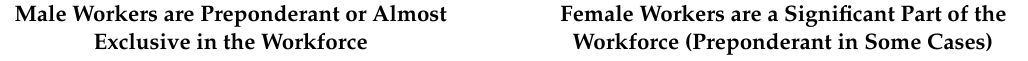
Table 1. A non-exhaustive list of outdoor working profiles and activities, distinguishing those with a prevalence of male workers from those with a significant presence of female workers. In some cases, an activity displays a prevalence of male workers together with a significant presence of female workers and is reported in both